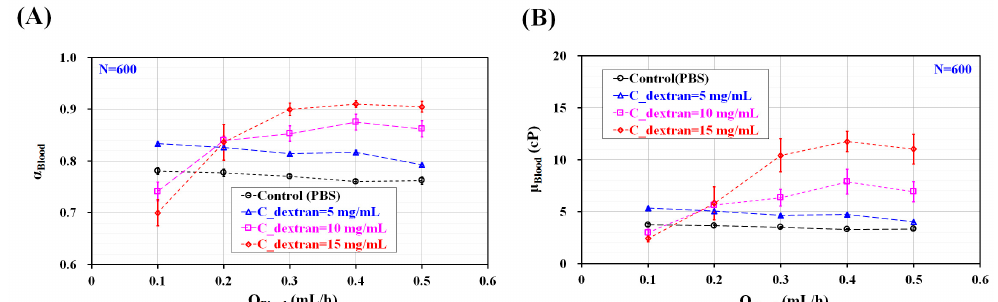
Figure 4. Quantitative evaluations of blood viscosity ( µ Blood ) under constant blood flow. Using various microscopic images as shown in Figure S1, α Blood was obtained by varying blood flow rate (Q Blood ) (Q Blood = 0.1 mL/h, 0.2 mL/h, 0.3 mL/h, 0.4 mL/h, and 0.5 mL/h) and concentration of dextran solution